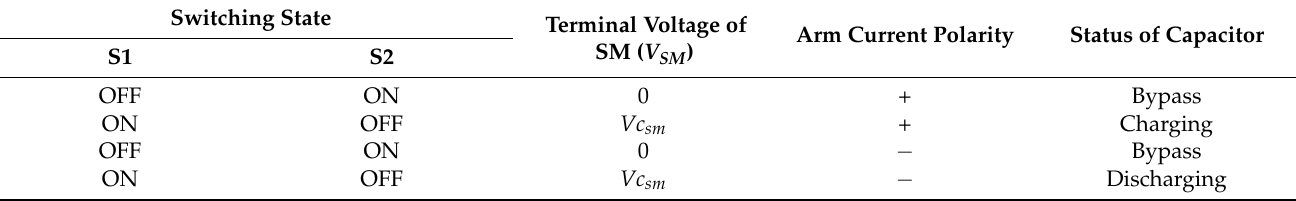
Table 1. Switching state of the Sub-Module